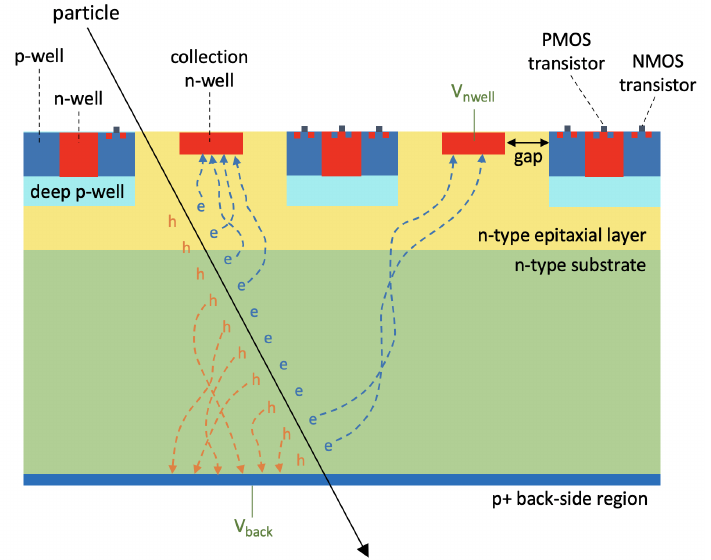
Figure 1. ARCADIA monolithic sensor concept. The dotted arrows indicate the drift path of electrons (e) and holes (h) generated by a particle crossing the sensor. The voltages V nwell and V back applied to the sensor contacts are shown in green. Not to